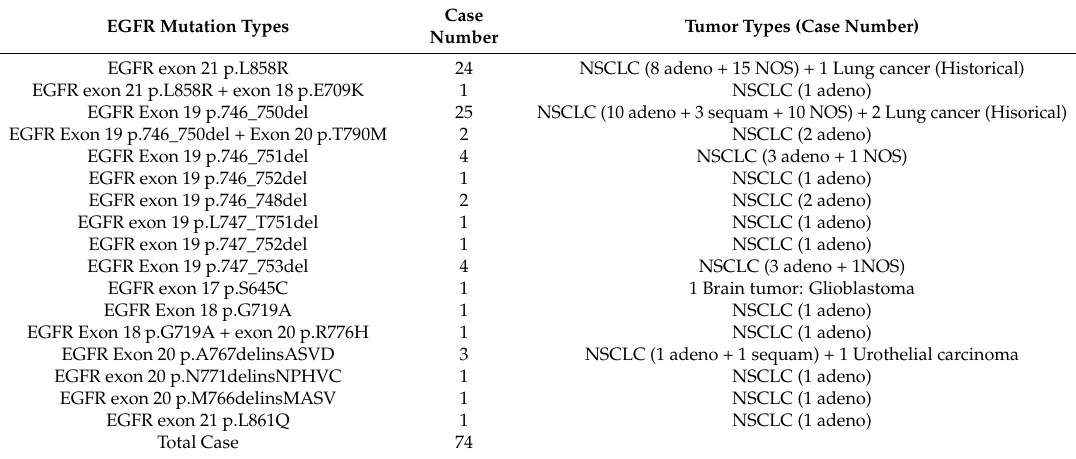
Table 2. Activating EGFR Mutation Types and Associated Tumor